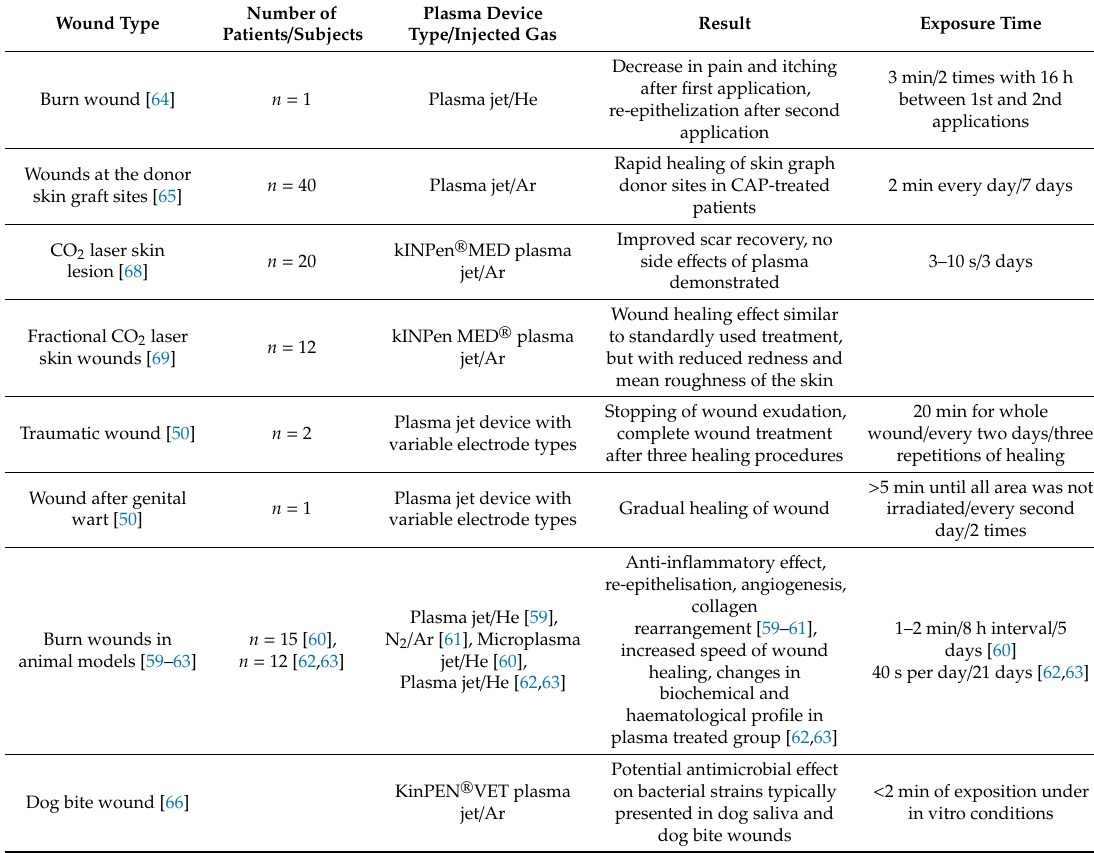
Table 2. List of cold atmospheric plasma (CAP) applications for acute wound